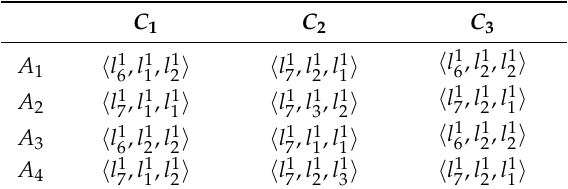
Table 2. The LNN decision matrix R 1 of the expert E 1 .